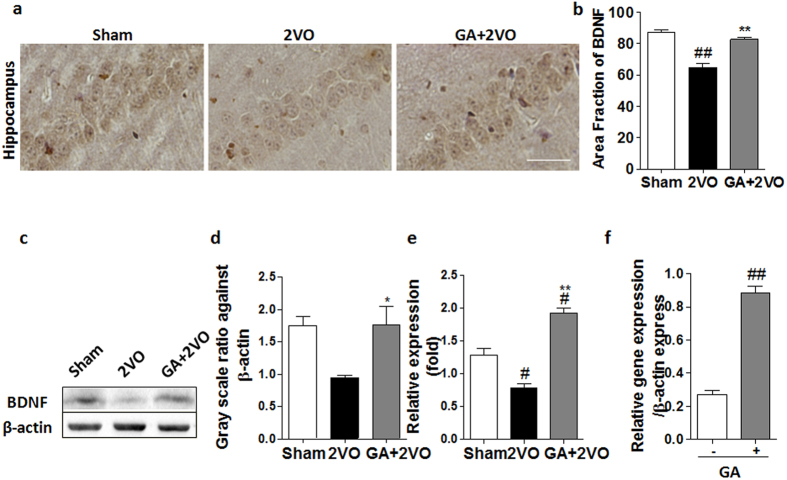
GA treatment increased the level of BDNF in hippocampus of 2VO rats.(a,b) As in representative immunohistochemical micrographs with statistical analysis, levels of hippocampal BDNF increased after GA treatment (magnification: 200×). Scale bar = 50 μm. n = 4 (c,d) Western blots of BDNF expression in the hippocampus and histograms show quantification of the GA effect on BDNF in the hippocampus. n = 5 (e) GA up-regulated the mRNA expression of BDNF in the 2VO model. n = 5 (f) Ex-vivo, secretion of BDNF by GA-reactive T cells increased significantly after stimulation of T cells with GA (50 ug/ml) compared to unstimulated T cells. The data of ex-vivo experiments of BDNF was tested for normality and evaluated by Student´s t-test (T) and other datas were subjected to ANOVA.The means ± SEM are shown (*P < 0.05 and **P < 0.01 as compared to 2VO group).